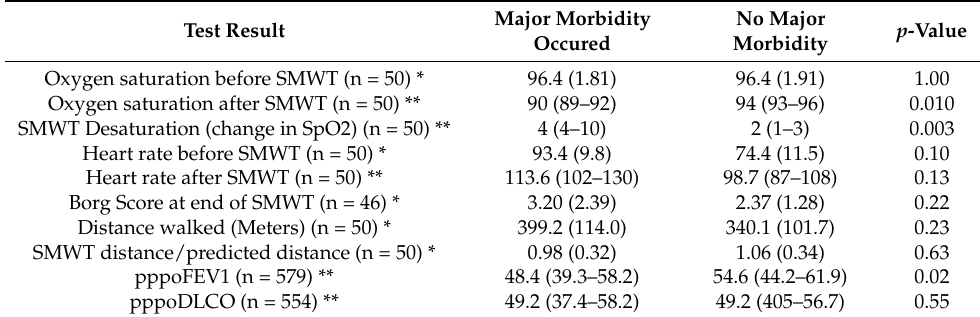
Table 2. The relationship of six-minute walk test (SMWT) and pulmonary function testing to perioperative major morbidity among 581 patients with pppoFEV1 or pppoDLCO values less ≤